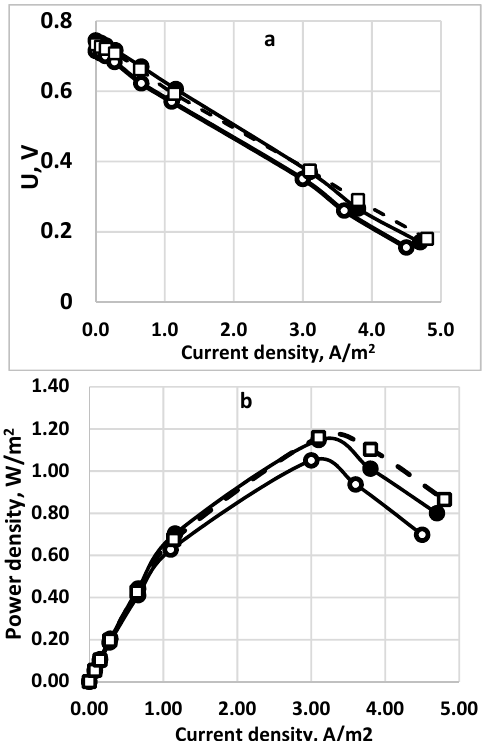
Figure 13. Comparison of the polarization curves ( a ) and the power densities ( b ) for three different membranes. Sulfide concentration—256 g dm − 3 . Supporting electrolyte—16 g dm − 3 . Active electrode and membrane surface—100 sq.cm. Feed flow rate—0.2 dm 3 /h. ( ○ ), solid line—Celgard 3501; (•), solid line—Neosepta*AFN; ( ○ ), dashed line - Fumapem* FFA-3-PK-75.